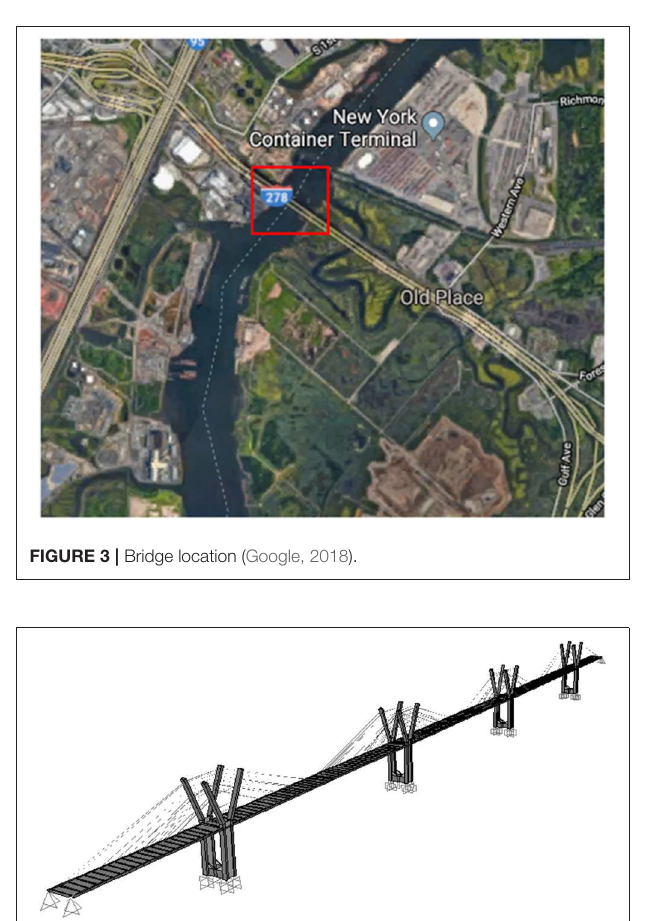
FIGURE 4 | 3D Elevation view of the cable-stayed bridge.